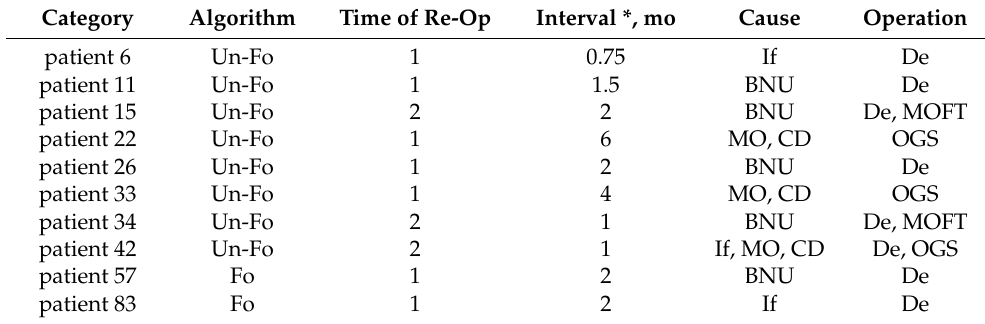
Table 3. Patients experienced